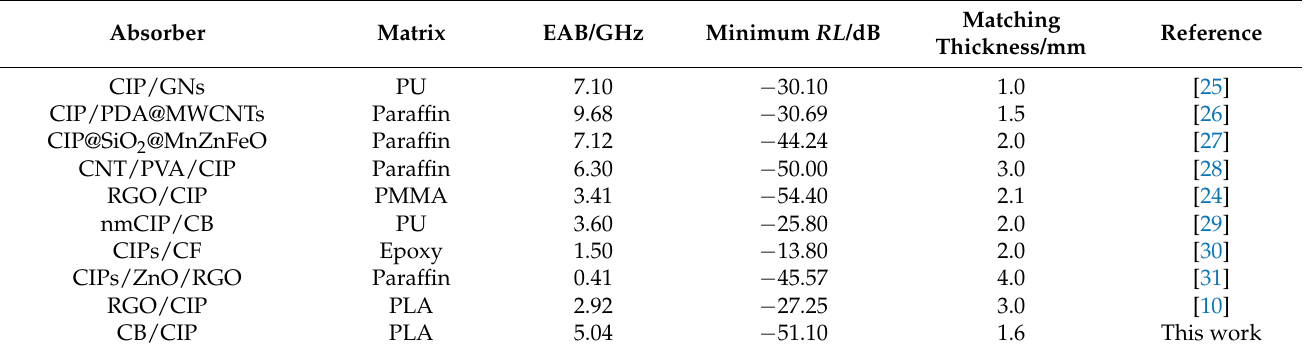
Table 3. Comparison of absorbing properties with the reported CIP composite materials.